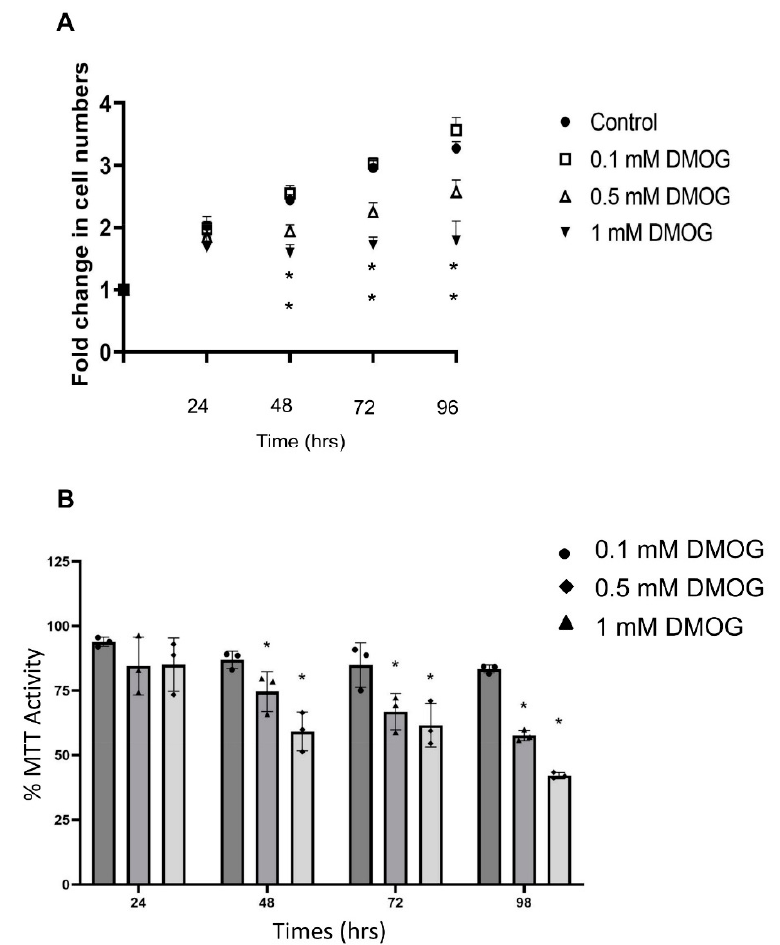
Figure 2. Effects of DMOG (0.1–1 mM) on PC12 cell proliferation and MTT activities. ( A ) Fold change in cell counts of PC12 cells under air oxygen (AO) following exposure to different concentrations of DMOG for a 96 h time-course. DMOG at 0.1 mM did not affect cell proliferation; however, DMOG at higher dose significantly inhibited cell proliferation at 48, 72 and 96 h. X-axis indicates time (h). Y-axis indicates fold changes in cell numbers. ( B ) MTT activity of PC12 cells in AO following exposure to different concentrations of DMOG across a 96 h time-course. MTT activities were significantly reduced by treatment with DMOG in a dose-related manner. X-axis indicates time (h). Y-axis indicates Abs. value normalised to Abs. of control at each time point. Data are expressed as mean + S.E.M, n = 3. Statistical significance of the assay was evaluated using one-way ANOVA with Tukey post hoc corrections. * indicates significant change in comparison to control at each time point ( p < 0.05).